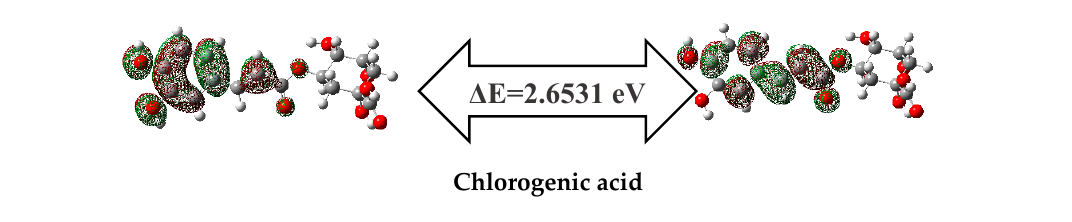
Figure 7. The shapes of frontier molecular orbitals HOMO and LUMO orbitals and energy gaps ( Δ E) of chlorogenic acid and Zn chlorogenates calculated at B3LYP/6-31G(d) level. The third mechanism, a sequential proton-loss electron transfer (SPLET) is realized by a two-